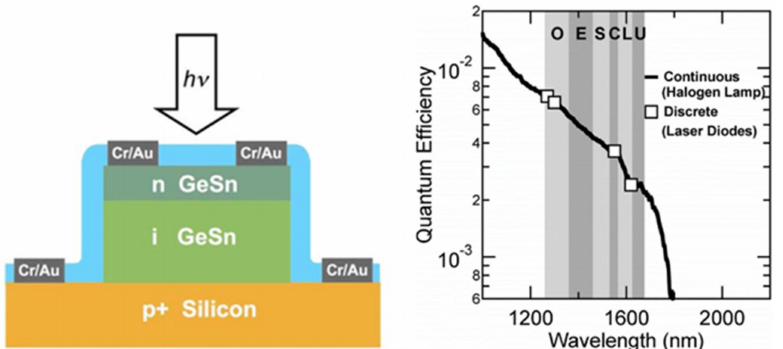
Figure 21. Cross-sectional schematic of a GeSn photodetector and its quantum efficiency as a function of wavelength. Reproduced with permission from [57], AIP Publishing,